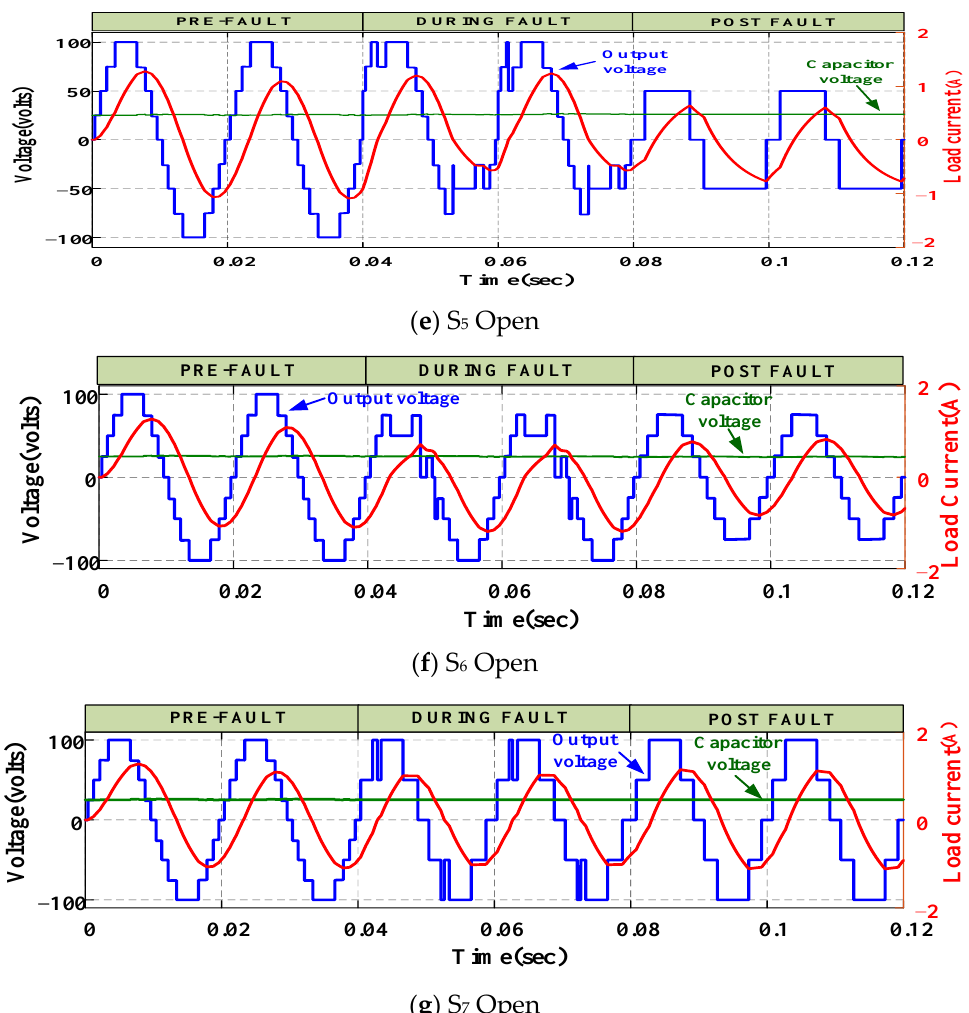
Figure 7. Waveforms obtained from the simulation for the voltage at the output, current through the load and voltage across the capacitor for pre-fault, faulty and post-fault conditions in: ( a ) S 1 or S 8 , ( b ) S 2 , ( c ) S 3 , ( d ) S 4 or S 9 ( e ) S 5 ( f ) S 6 and ( g ) S 7 .